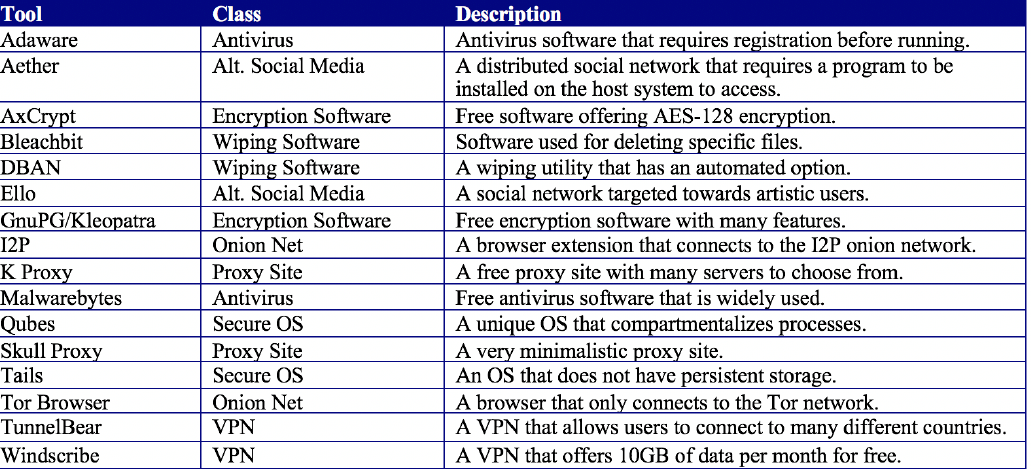
Figure 3. Tools that were tested for this